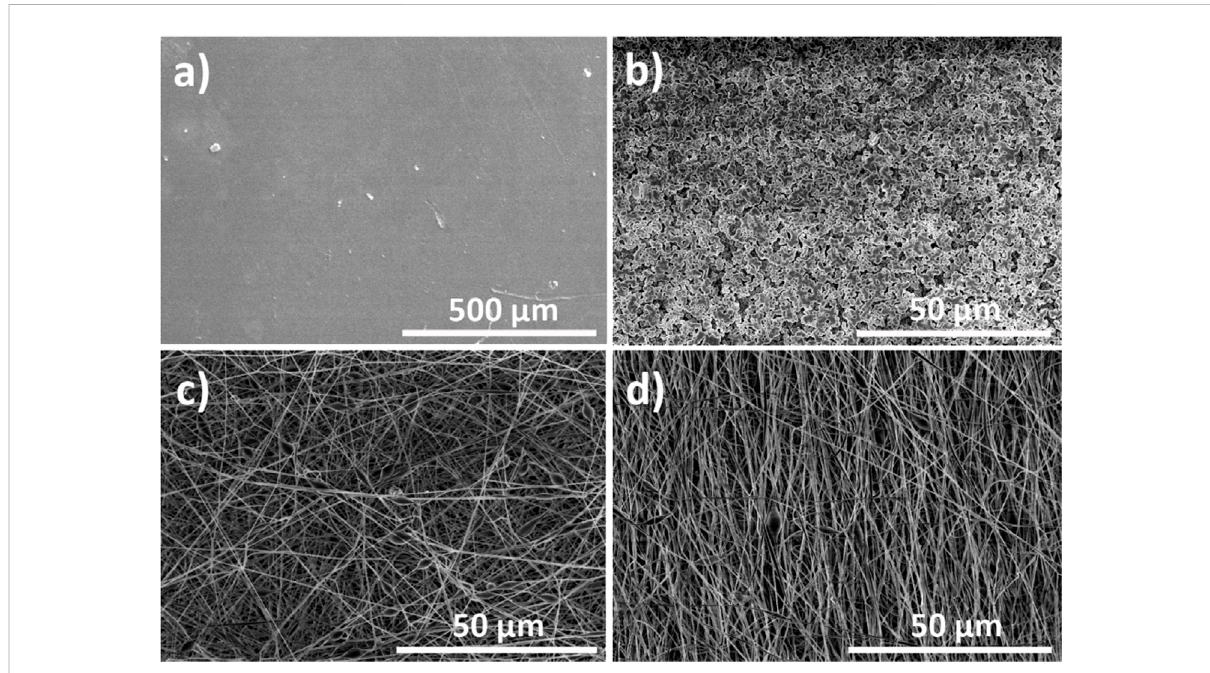
FIGURE 1 Representative SEM images of the processed PVDF structures, namely: (A) fi lms, (B) porous scaffold, (C) electrospun randomly-oriented fi bers, and (D) electrospun oriented fi bers.